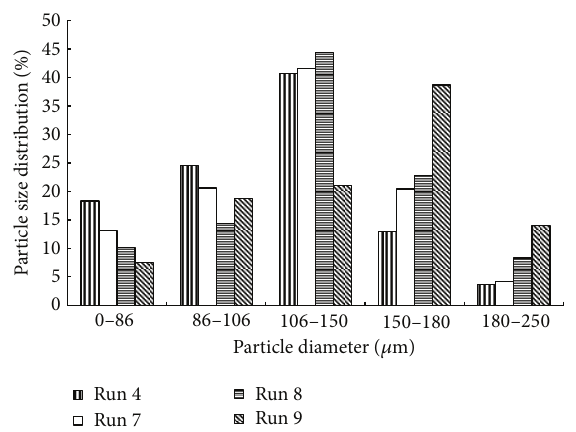
Figure 5: Effect of feed moisture on particle size distribution of pulverized biomass.